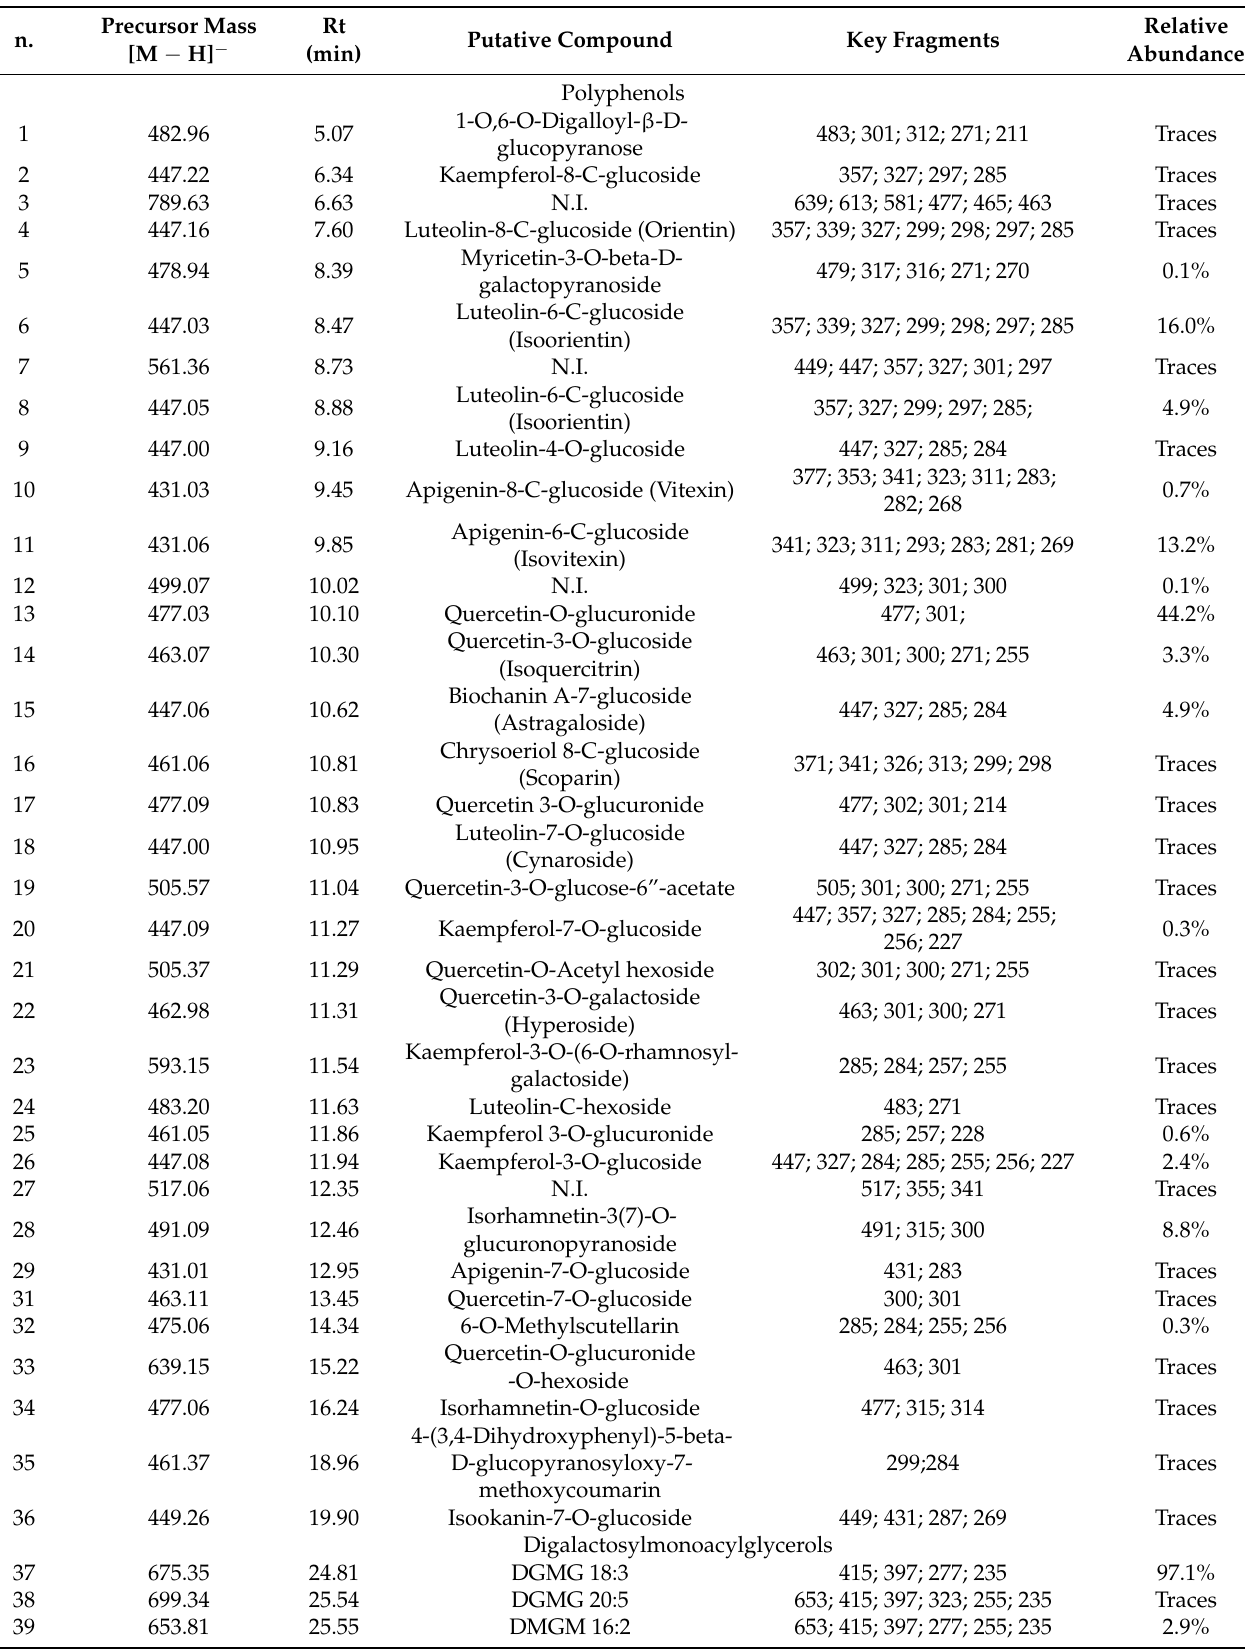
Table 2. Putative assignments of the nodes from the V. vinifera molecular